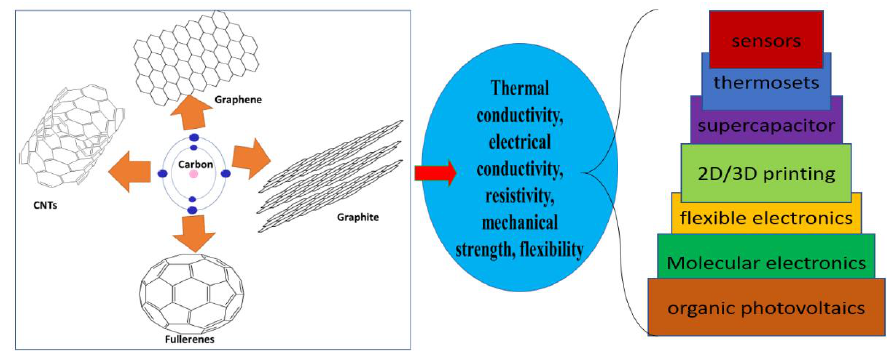
Figure 1. Brief description of various carbon allotropes, their electronic properties and applications in electronic industries.